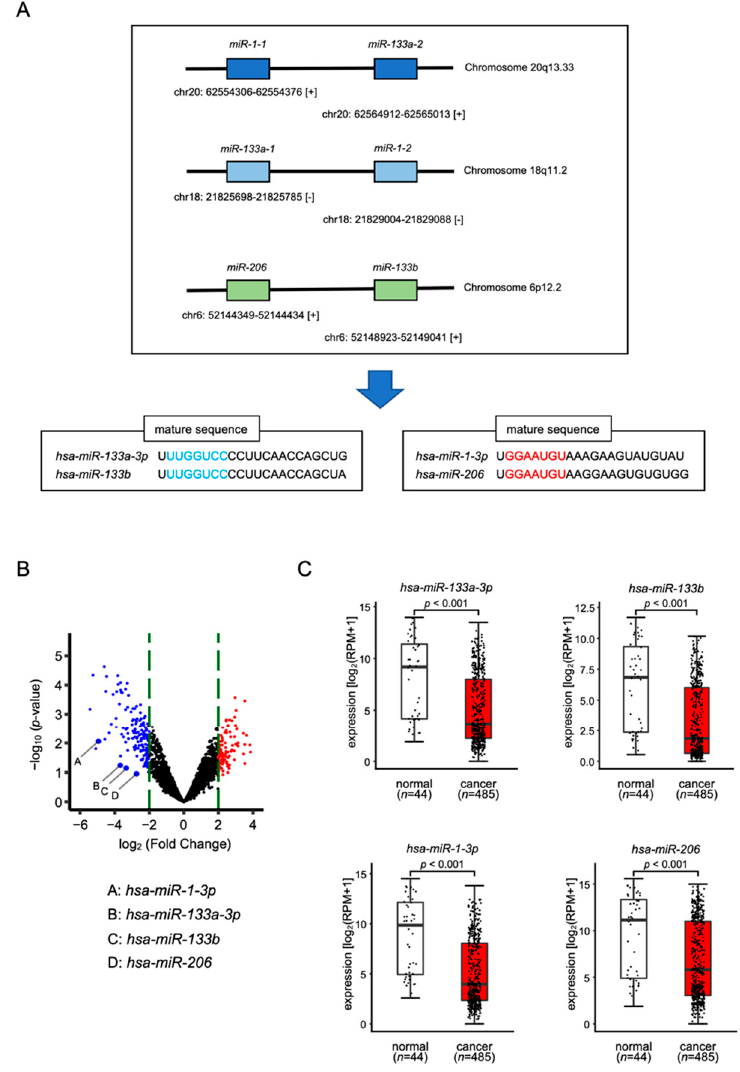
Figure 1. Expression levels of miR-1 / miR-133 clustered miRNAs in HNSCC clinical specimens. ( A ) The chromosomal location of each microRNA. Mature seed sequences of miR-133a-3p / miR-133b were identical. Mature seed sequences of miR-1-3p / miR-206 were identical. ( B ) Volcano plot of the miRNA expression signature determined through small RNA sequencing. The log 2 -fold change (FC) is plotted on the x -axis, and the log 10 ( p -value) is plotted on the y -axis. The blue points represent the downregulated miRNAs with an absolute log 2 FC < − 2.0. The red points represent the downregulated miRNAs with an absolute log 2 FC > 2.0. ( C ) The expression levels of miR-133a-3p / miR-133b and miR-1-3p / miR-206 were evaluated in an HNSCC data set from